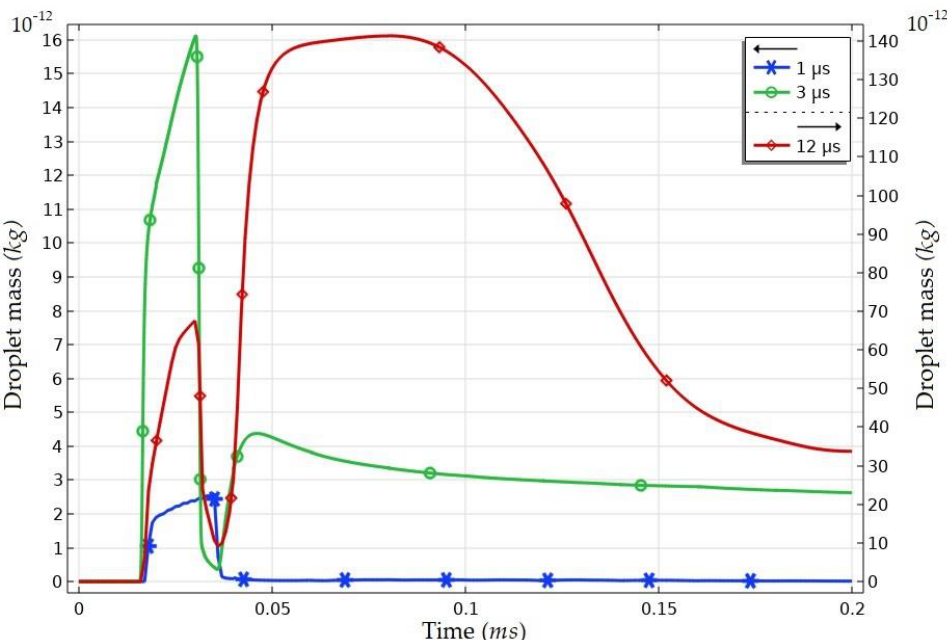
Figure 6. Representation of the droplet mass turnover. Mass versus formatting time.